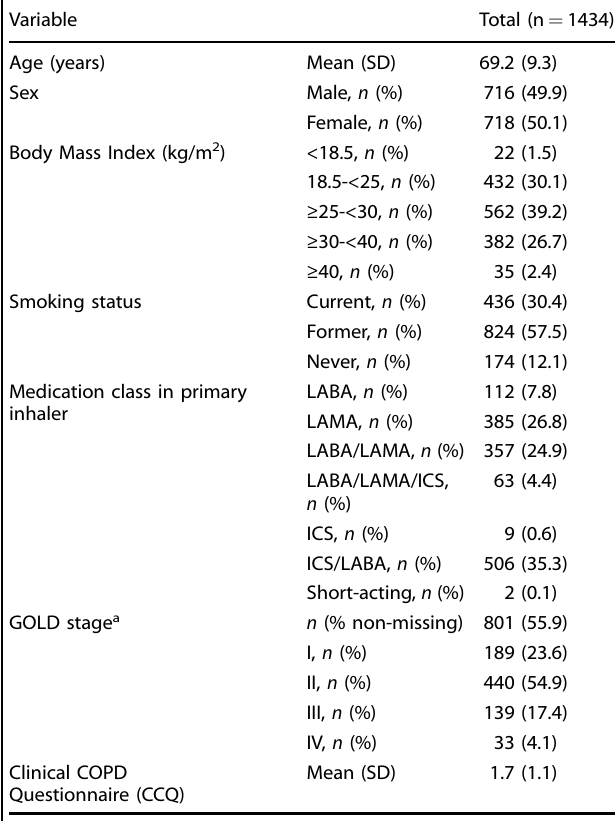
Table 1. Overview of patient